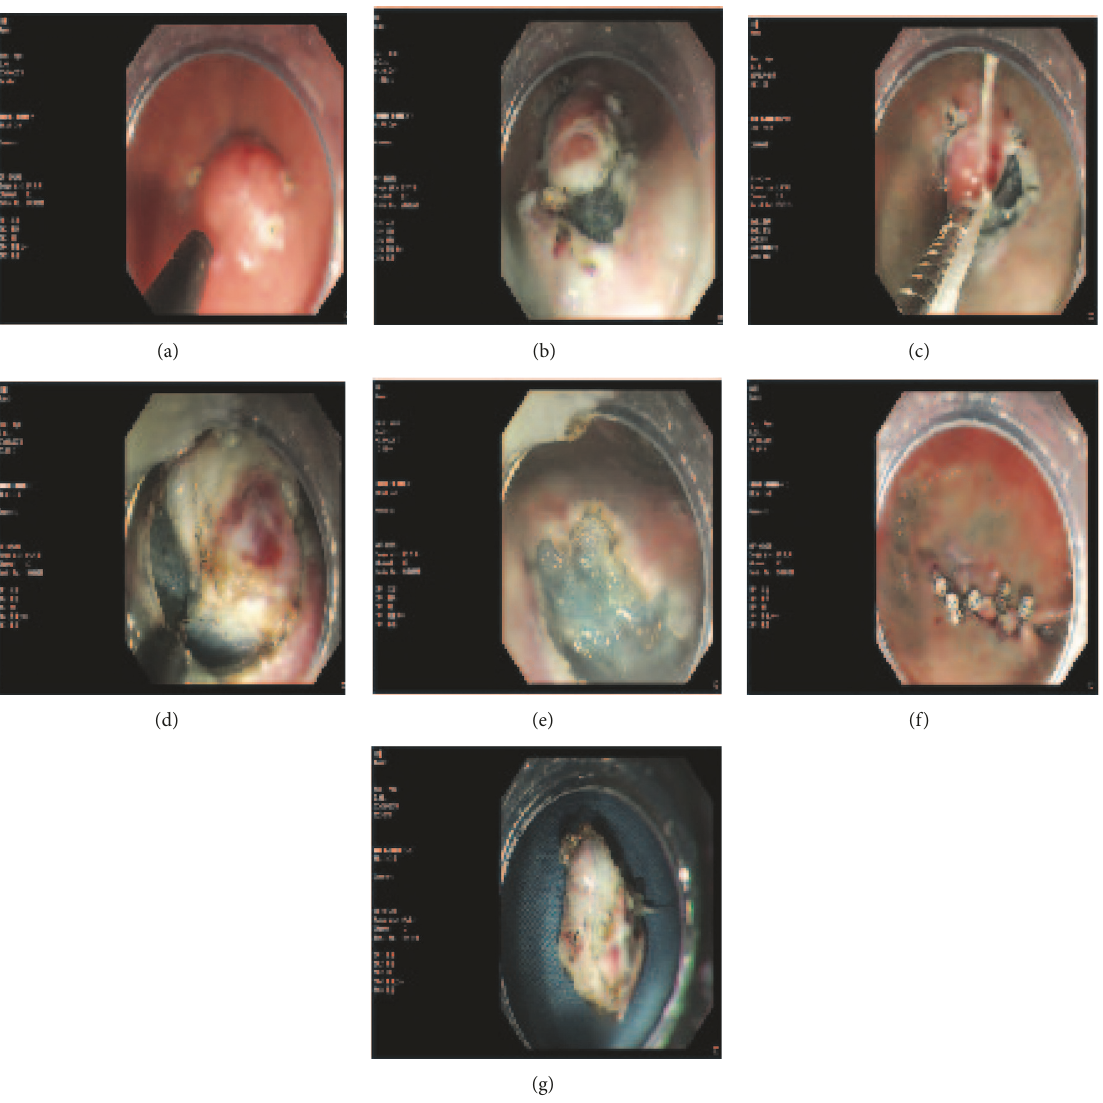
Figure 2: ESD with dental floss clip traction. (a) A bump was seen in the gastric fundus (endoscopic ultrasound showed it originated from the muscular layer, 1.5cm in diameter), labeled with Hook Knife. (b) Hook knife cut off most part of the mass along the labeled margin, while the endoscopic transparent cap could not enter into the gap between the lesion and normal tissue, which led to difficulty of the resection. (c) The clip fixed the dental floss right in front of the endoscopic vision. (d) After the traction, the lump was clearly defined by the normal tissue, and the HK knife was easy to peel off the lump. (e) The post-ESD wound has no defect left. (f) The wound was closed with titanium clips. (g) The